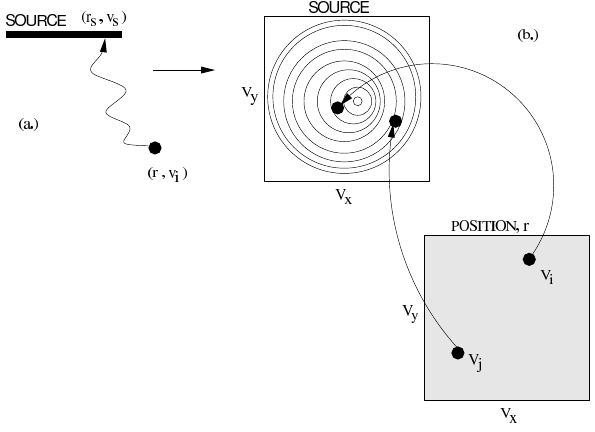
Fig. 6. (a) The diagram illustrates how pseudo-particles, with ini- tial position and velocity (r,v i ) move through space to a source region. (b) The upper distribution function shows contours of con- stant phase space density. Numerous pseudo-particles are followed from unique initial locations in velocity space (lower distribution) to the source (upper distribution). Since the velocity distribution is known at the source, Liouville’s theorem allows each initial pseudo- particle to be tagged with a known phase space